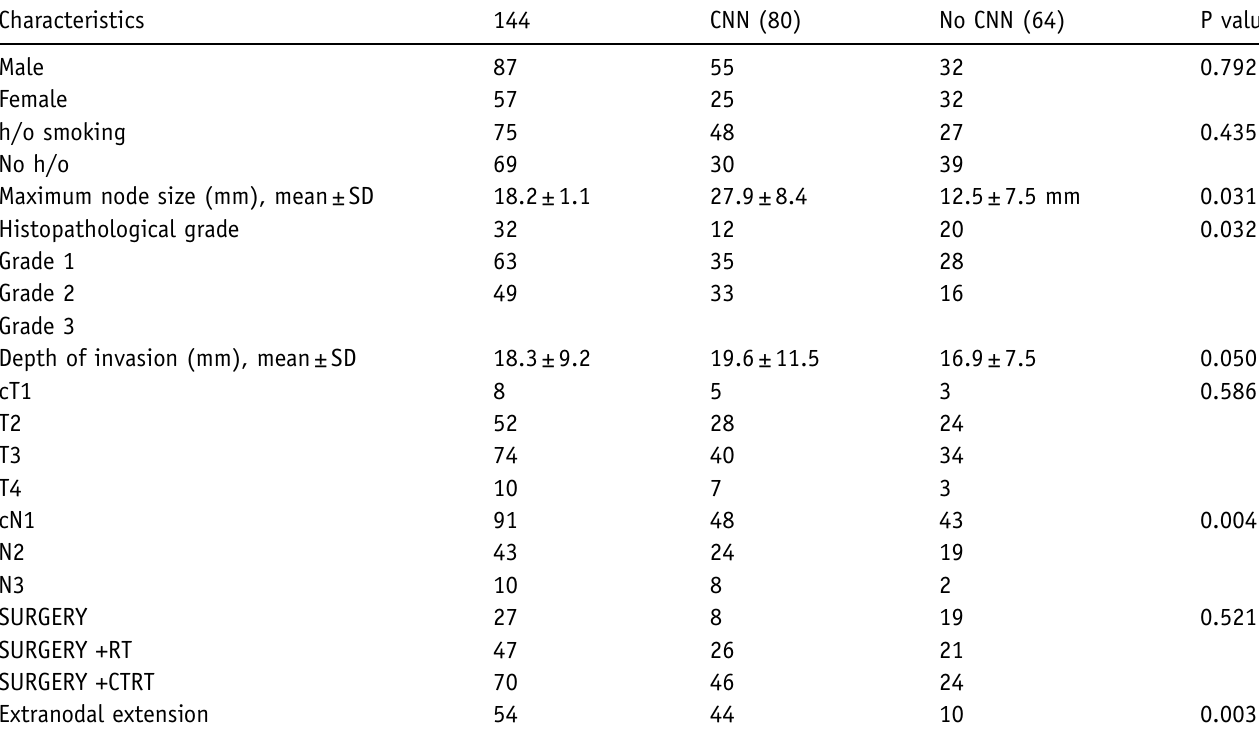
Table I. Clinical and Pathologic Characteristics of Patients with SCC of Tongue With Cervical Nodal Necrosis (CNN) (CNN Group) or Without CNN (Non-CNN Group) on Preoperative MR Imaging.